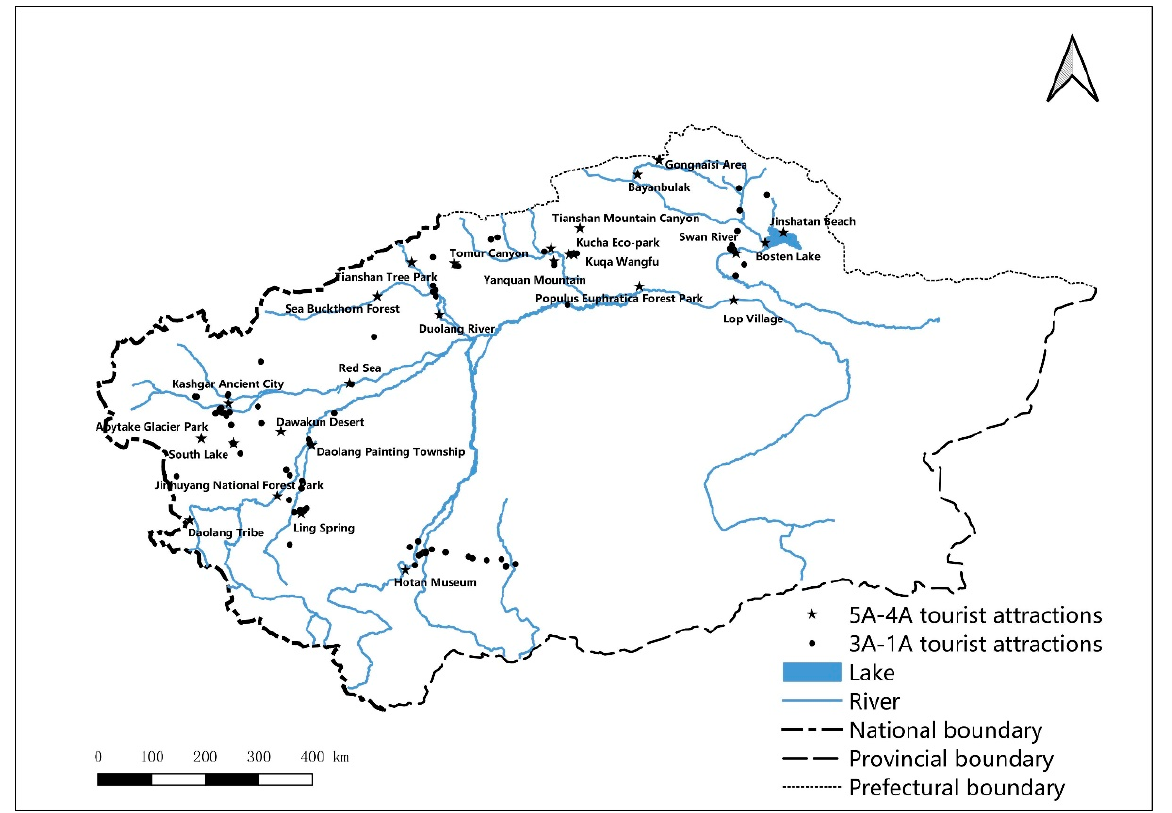
Figure 2. Distribution of A-level tourist attractions in the Tarim River Basin, Xingjiang, China.